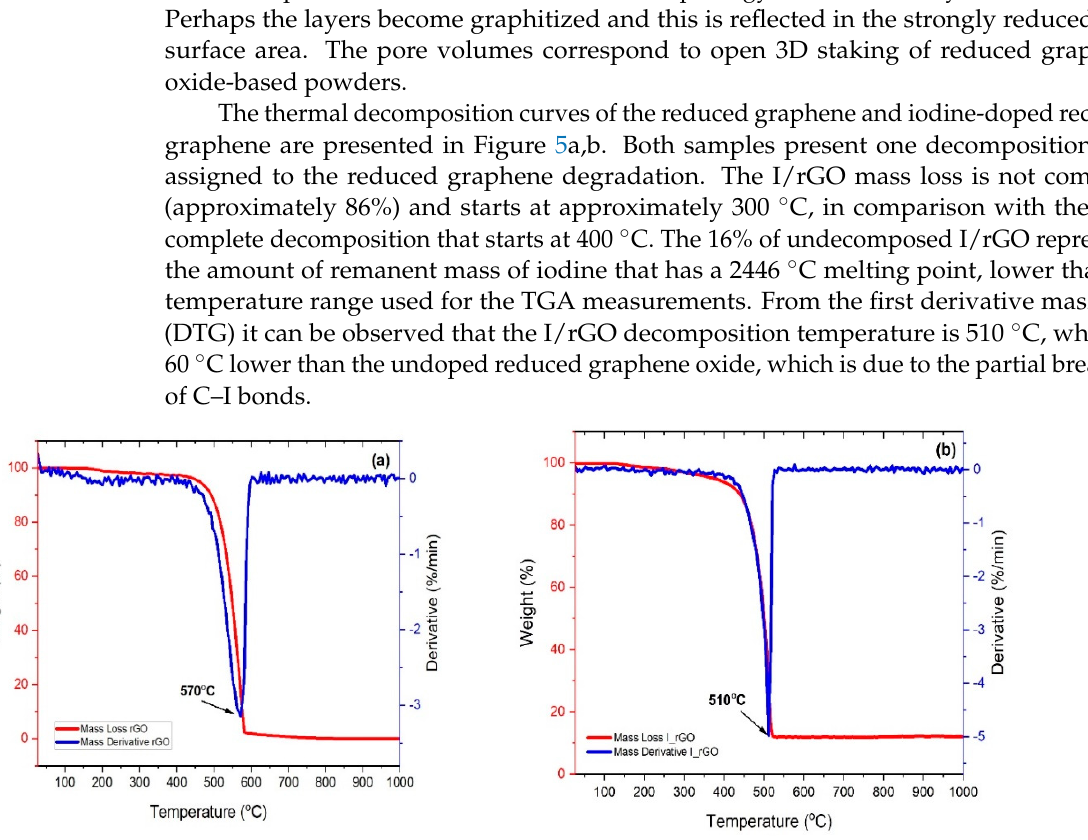
Figure 6. Overlaid ATR − FTIR rGO and I/rGO spectra with the fingerprint zone in the inset. The catalytic performance of rGO and I/rGO for the oxygen evolution reaction (ORR) was characterized in alkaline electrolyte (0.1 M KOH) using the cycling voltammetry method (CV) at 50 mV/s [12]. In Figure 7 are presented the rGO and I/rGO cycling volt- ammograms (CVs) scanned with a scan rate of 50 mV/s. Analyzing the I/rGO CV, it can be noticed that the oxygen reduction (ORR) peak from − 0.343 V is approximately twice higher (current density of 3.3 mA/cm 2 ) in comparison with 1.52 mA/cm 2 from 0.383 V of rGO, respectively. Moreover, the I/rGO ORR peak position is shifted with 50 mV to a more positive potential. These findings strongly indicate that the iodine-doped reduced gra- phene oxide have ORR catalytic activity. The influence of the sweeping towards the I/rGO CV shape and ORR current density is presented in Figure 7b. The results show a shift to more oxidative potentials (left side), and an enhancement of the cathodic peak with a sweeping rate, from 7.4 mA/cm 2 corresponding to 10 mV/s, to 24 mA/cm 2 associated with